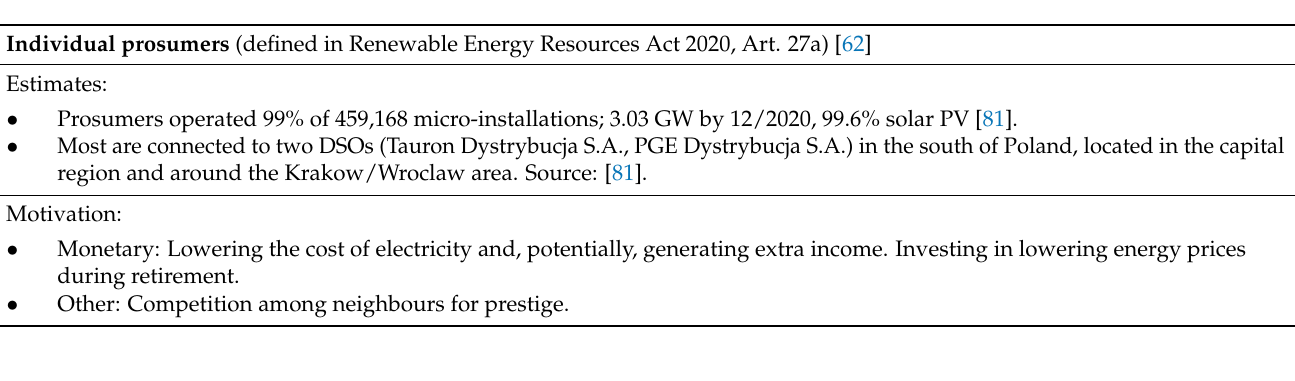
Figure 20. Confidence in institutions. Source of data: WVS [50].